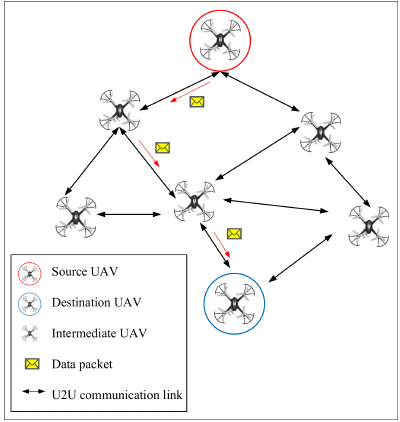
Figure 16. Flat routing scheme. Table 4. Comparison of hierarchical and flat routing